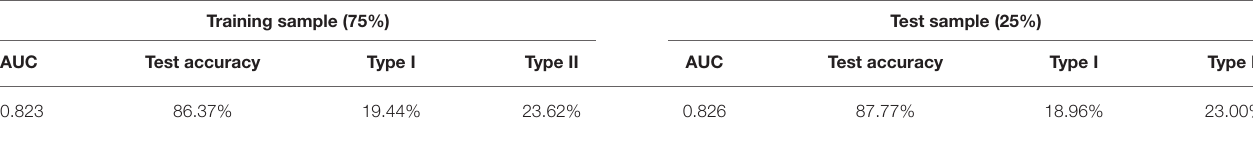
TABLE 5 | AUC, Type I errors, and Type II